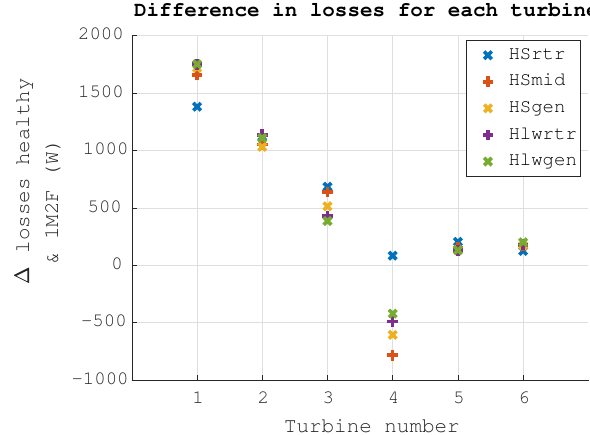
Figure 8. Dataset 2 thermal network model results.